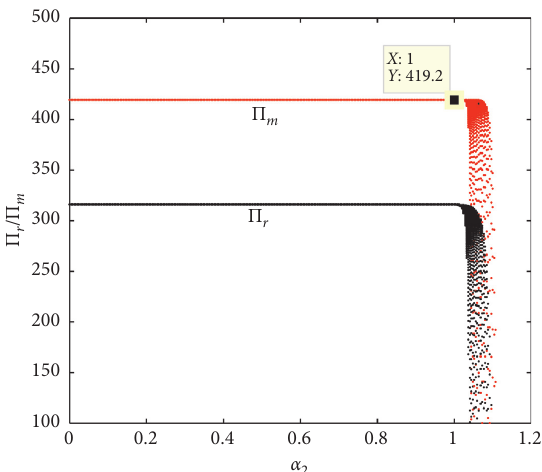
Figure 14: The wave-shape chaos diagram of 􏽑